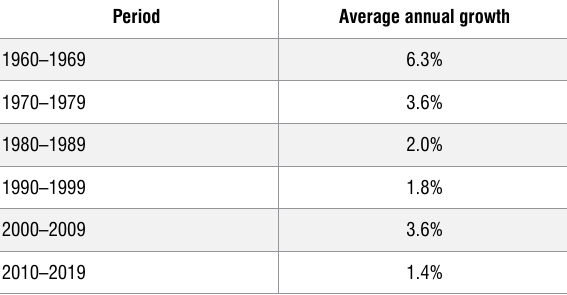
South African GDP growth (2015 Rand) 17